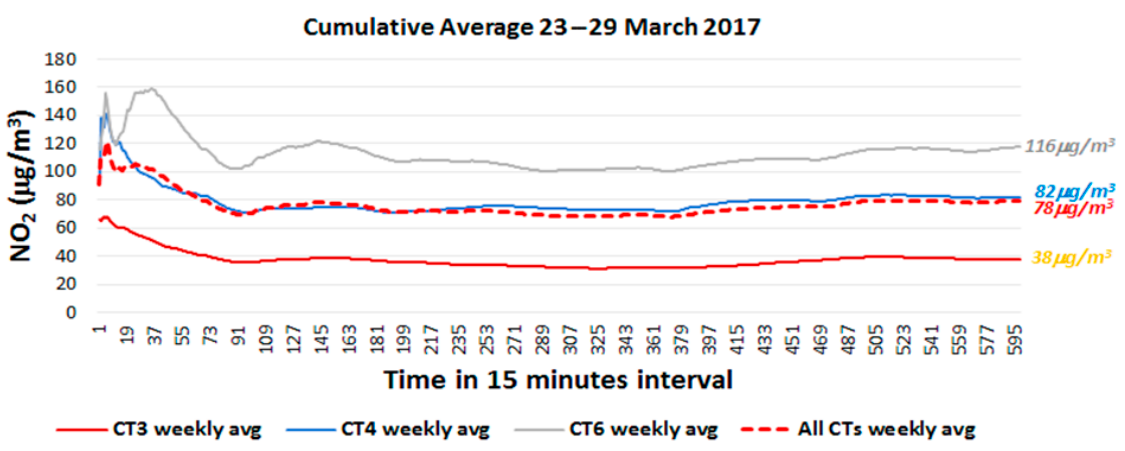
Figure 7. Cumulative average NO 2 Concentrations (µg/m 3 ) at CoL CMS for the full Smogmobile Survey Period.